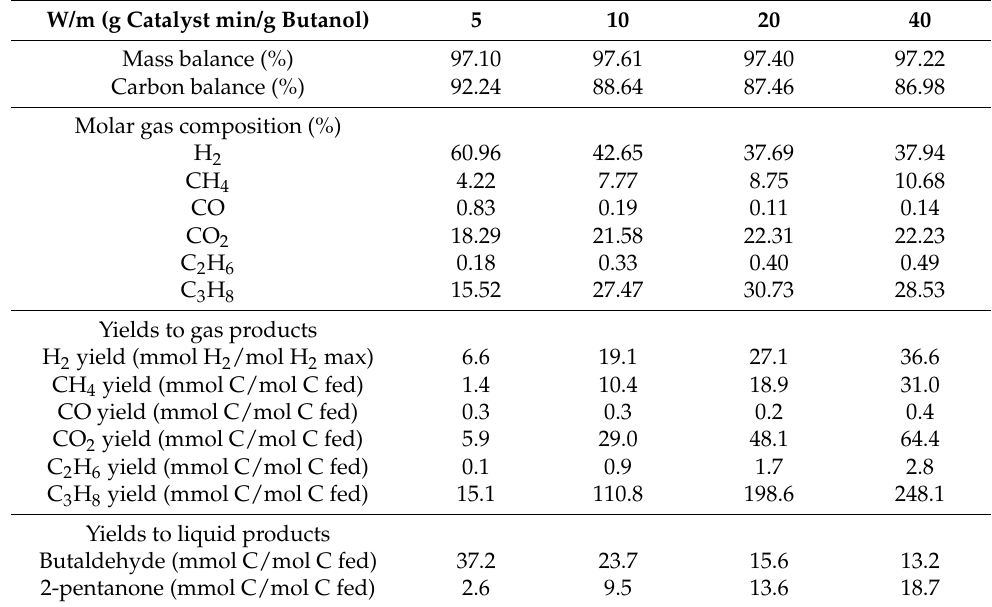
Table 3. Results of the APR experiments of butanol (T = 227 ◦ C, 40 bar, 5 wt% butanol, Ni-Co/Al-Mg catalyst, 1 mL/min aqueous feeding